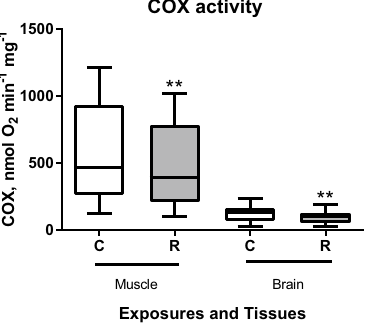
Figure 3. Effect of the H-R stress on the indices of mitochondrial coupling and cytochrome c oxidase (COX) activity in the permeabilized skeletal muscle and brain cells of S. scrofa. Conditions: C—normoxic (control) cells, R—cells after 15 min of severe hypoxia followed by 10 min of reoxygenation. Asterisks indicate significant differences in the respective traits between the control and reoxygenation conditions (** P <0.01). N=8 for the skeletal muscle and 7 for the